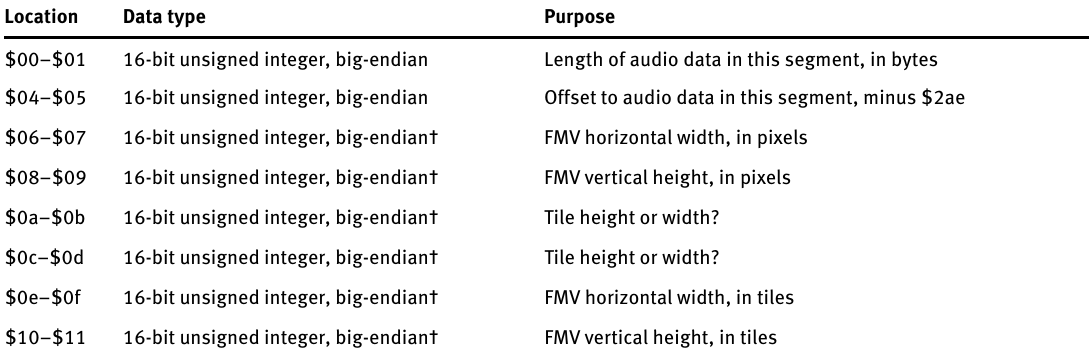
Table 3. SH FMV segment header fields.